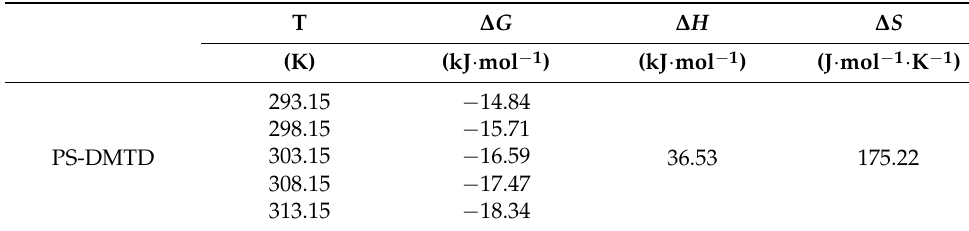
Table 4. The values of ∆ H , ∆ S , and ∆ G